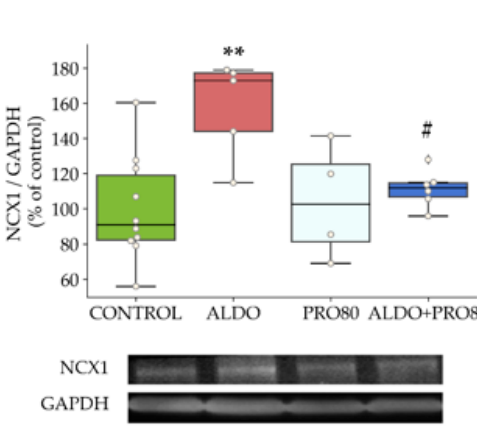
Figure 3. Effect of aldosterone-induced massive entry of sodium; role in NHE1, NKA and NCX1 expression. Relative protein expression levels by western blot of: ( A ): The sodium–hydrogen exchanger type 1 (NHE1), ( B ): The Na+/K+ ATPase pump (NKA) and ( C ): The sodium-calcium exchanger type 1 (NCX1). The boxplots show median, first and third quartile, and minimum and maximum values; the dots show individual values. ** p < 0.01 vs control; # p < 0.05 vs ALDO. CONTROL: Control group; ALDO: Aldosterone-salt group; PRO80: Proanthocyanidins-80% enriched extract group; PRO80+ALDO: Aldosterone plus proanthocyanidins-80% enriched extract group ( n =8).